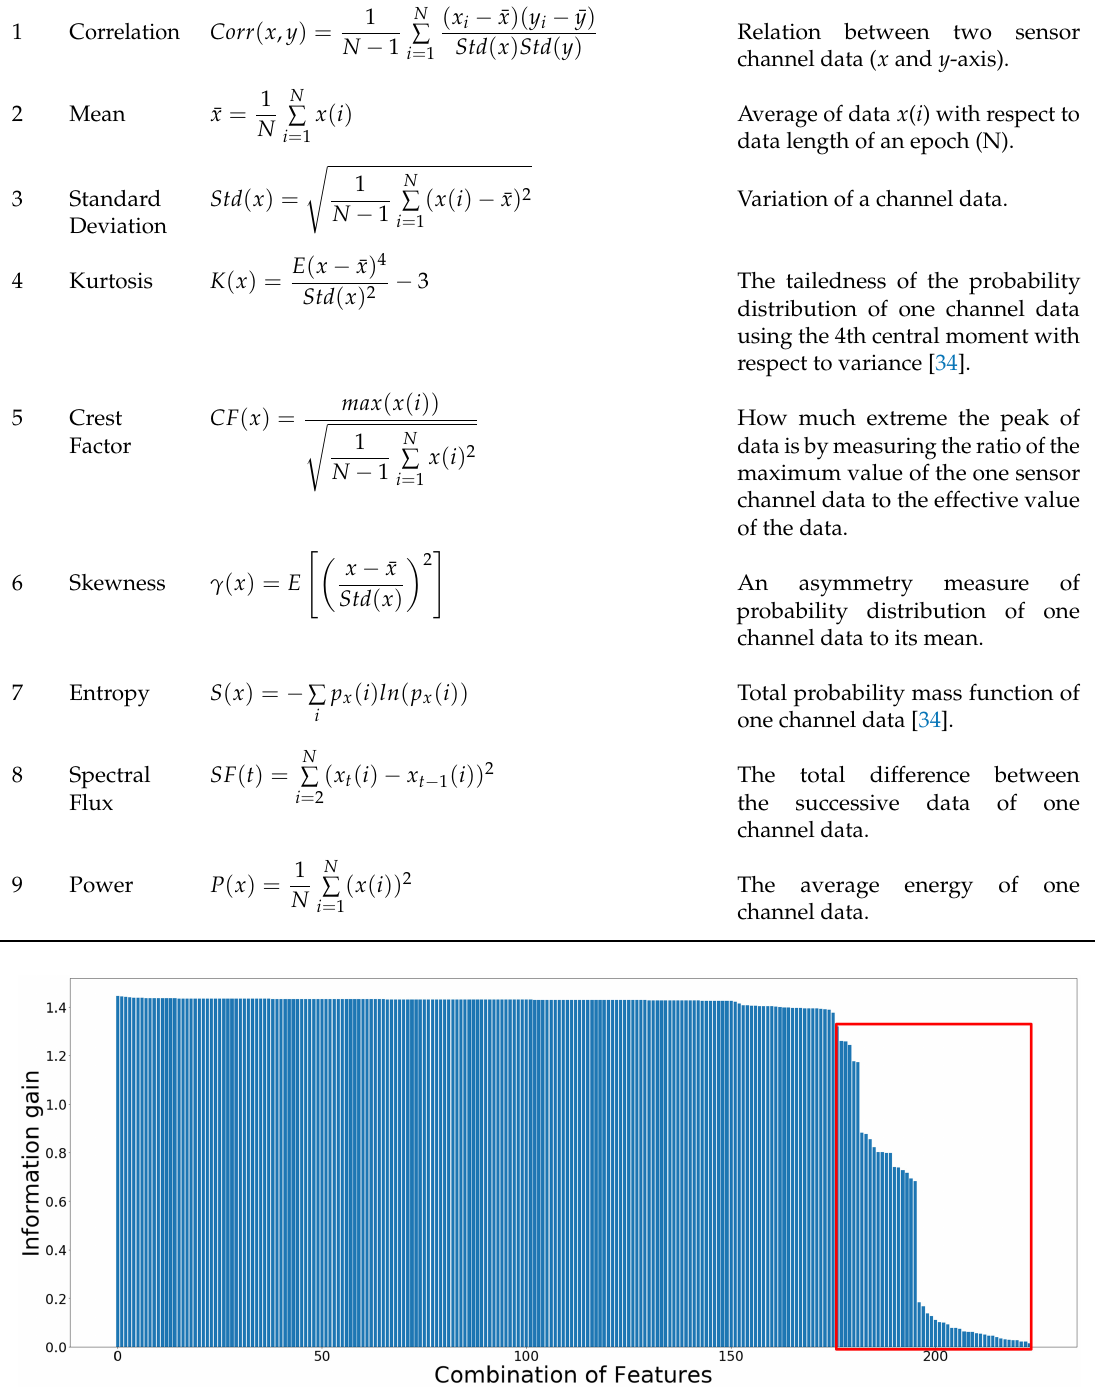
Figure 4. Information gain calculated from 224 features of 20 channels sensor